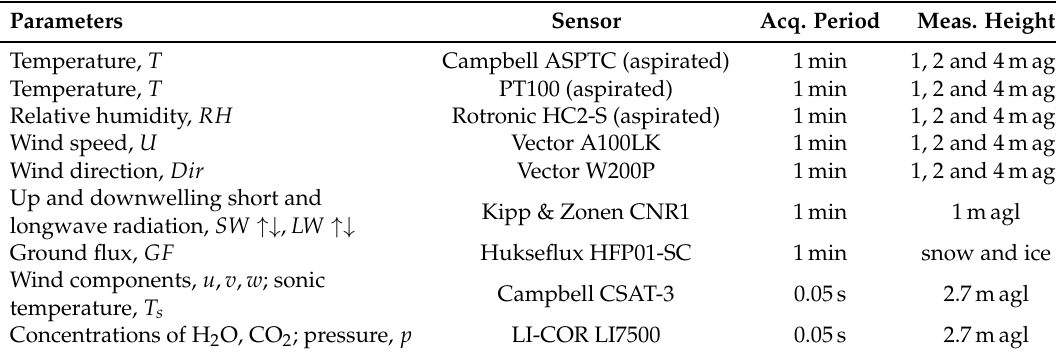
Table 2. Specifications of the automatic weather station